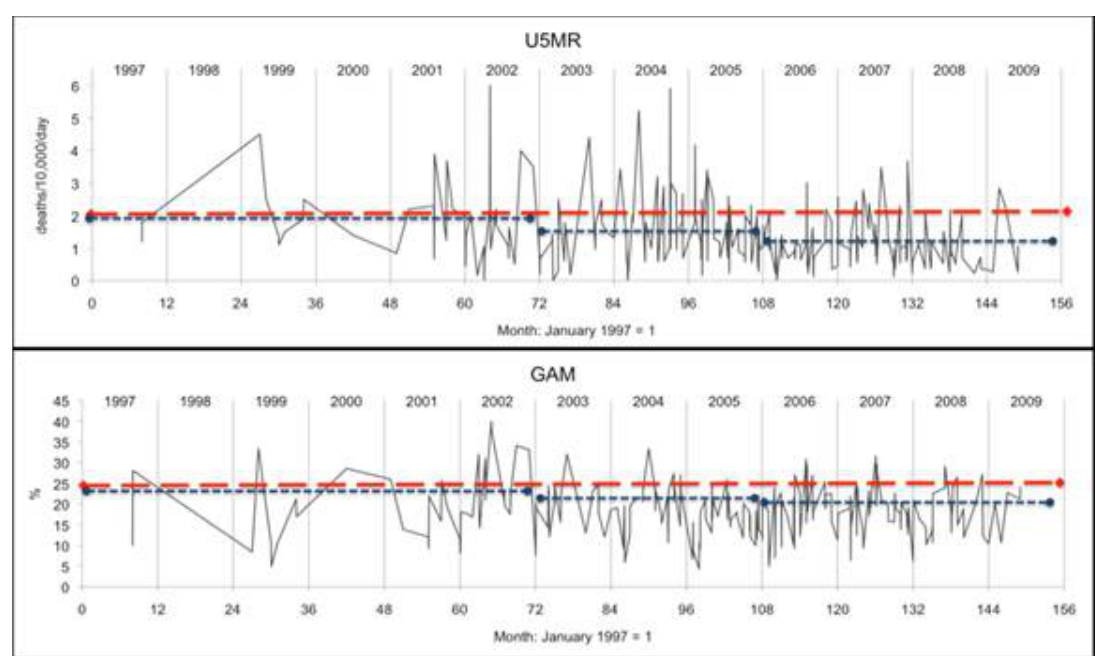
Figure 1. Patterns of survey results: malnutrition (GAM) and child mortality (U5MR) plotted by month of